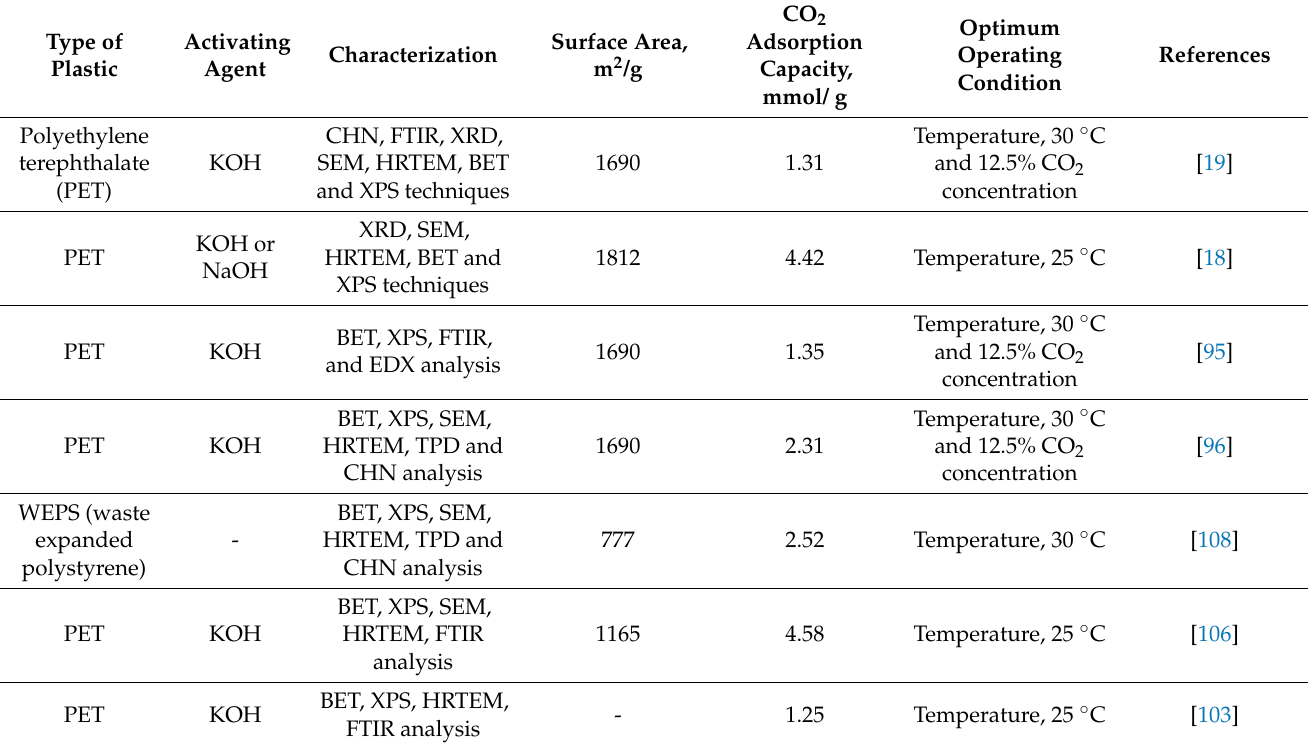
Table 8. Summary of plastic waste as adsorbent for CO 2